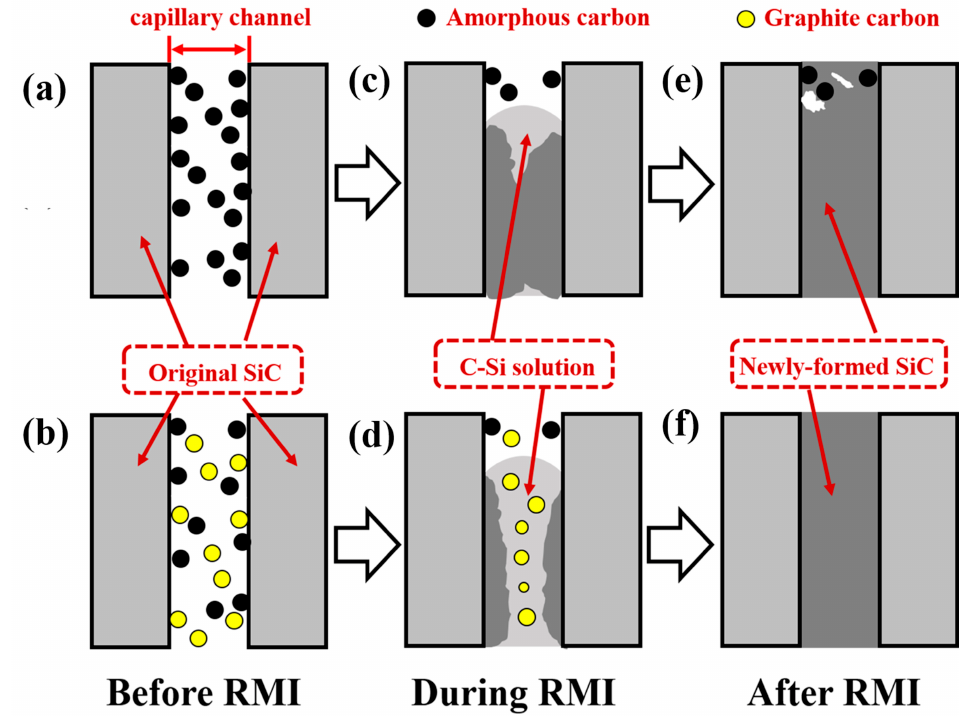
Figure 7. Schematic of reaction process between carbon and liquid Si: ( a ) the amorphous carbon in capillary, ( c ) the reaction between amorphous carbon and liquid Si, ( e ) the phenomenon of pore- clogging; ( b ) the multiphase carbon in capillary, ( d ) the reaction between multiphase carbon and liquid Si, ( f ) the phenomenon of the pore-clogging was avoided.